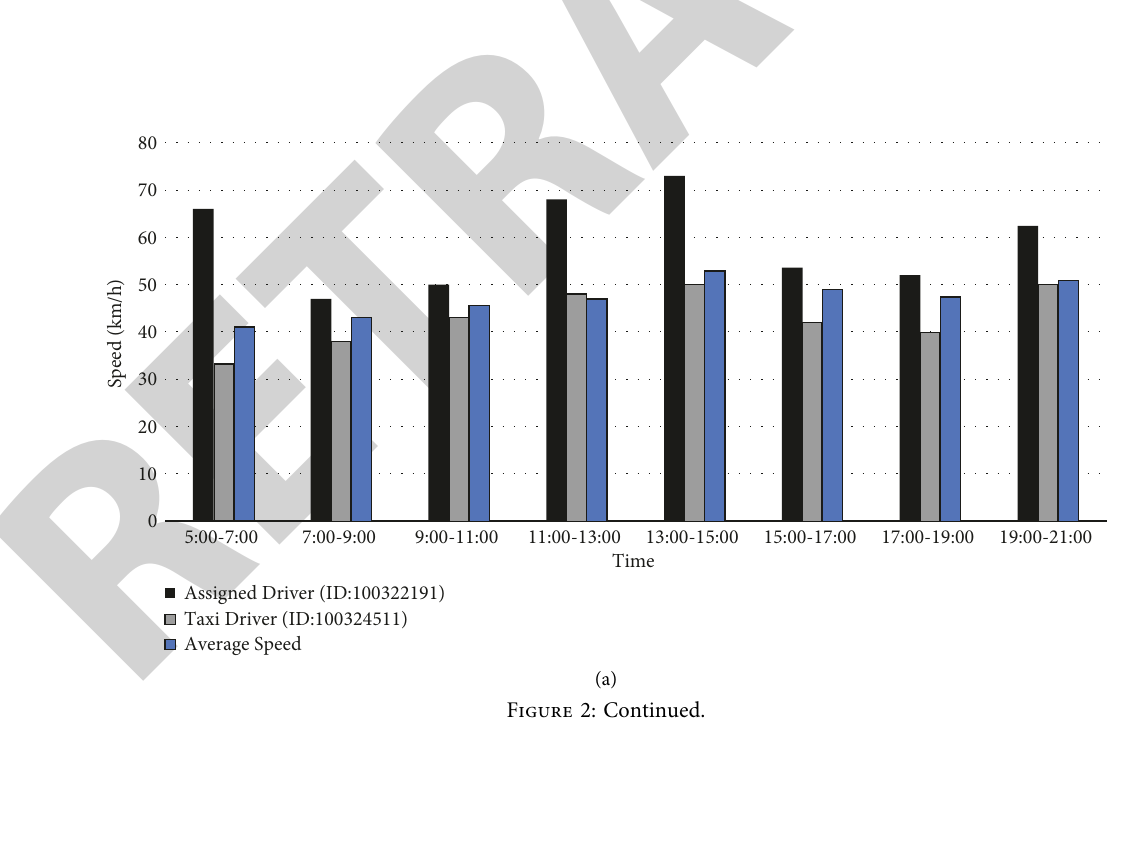
Figure 1: The spatial-temporal correlation on each road segment and interdependence between road